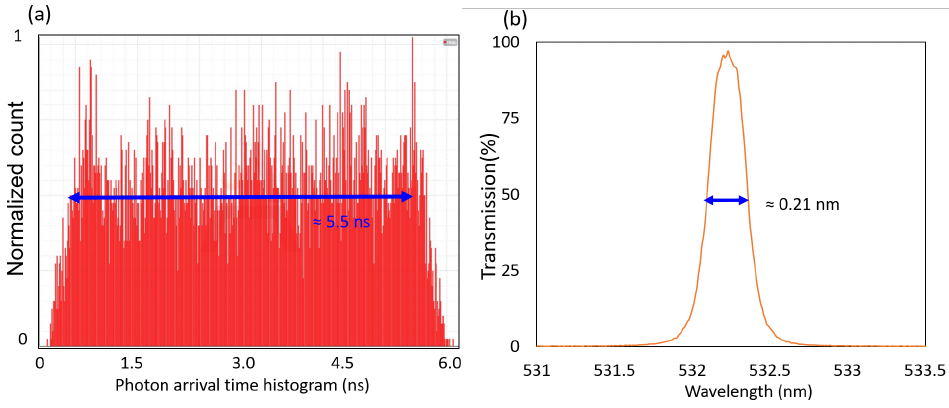
Figure 2. ( a ) Time-tagging histogram of the time-gated single-photon detector dark counts (without optical signal input) showing the minimum effective temporal gate width of ≈ 5.5 ns. ( b ) Spectrum of the optical bandpass filter obtained using a broadband light source and an optical spectrum analyzer. The filtering window of the laser source was calibrated at the center wavelength of 532.2 nm with an FWHM of 0.21